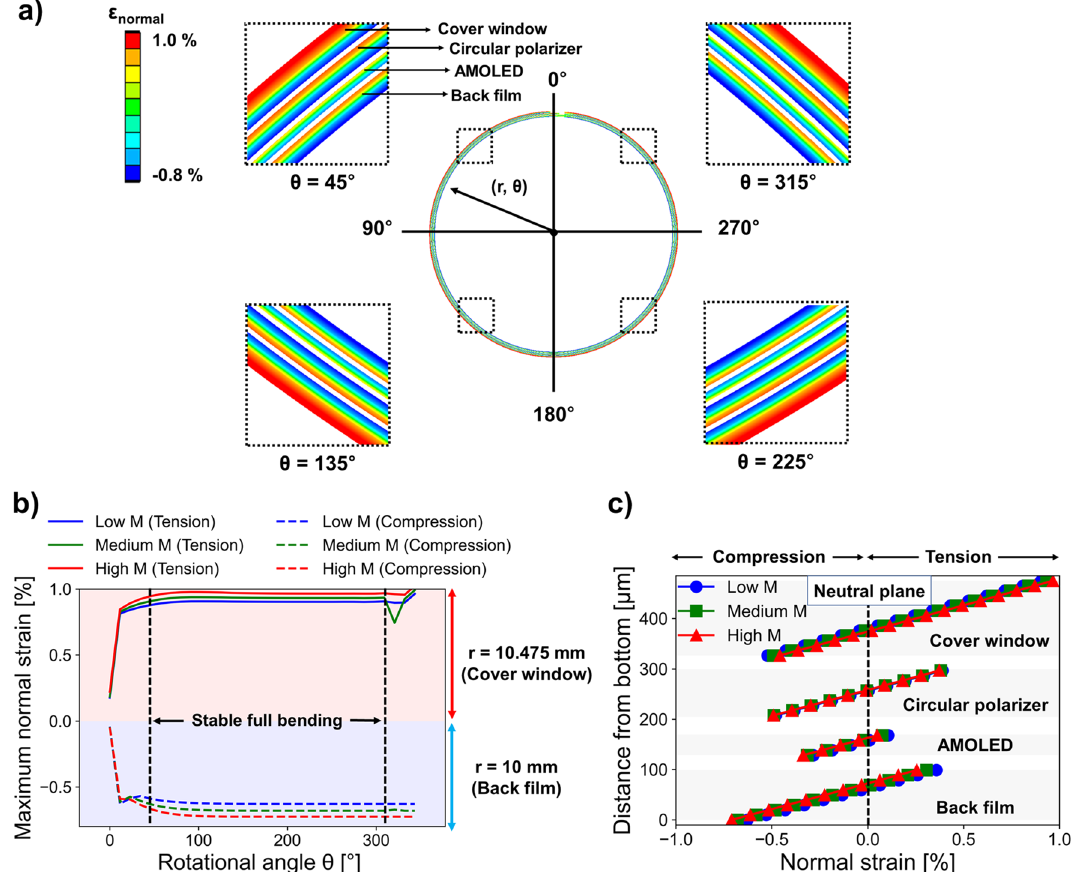
Figure 5. Finite element method (FEM) results on the behaviors of rigid functional layers in rolling deformation. ( a ) FEM images showing the normal strain distributions based on the use of OCA with a mid- modulus value. ( b ) Measurements of maximum tensile and compressive strains depending on the rotational angle. ( c ) Normal strain distributions at the cross-section of rigid functional layers at θ =